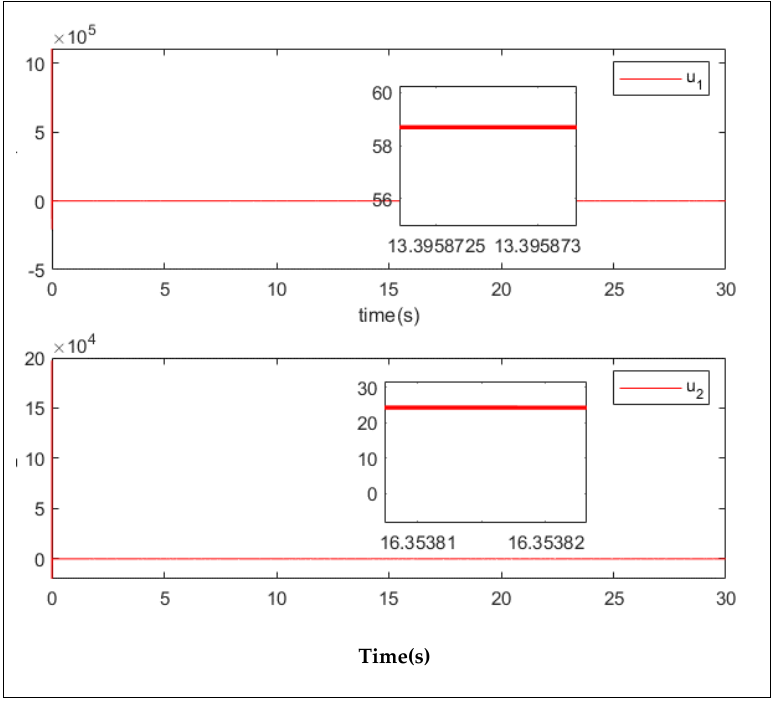
Figure 9. Control input in the tenth iteration.